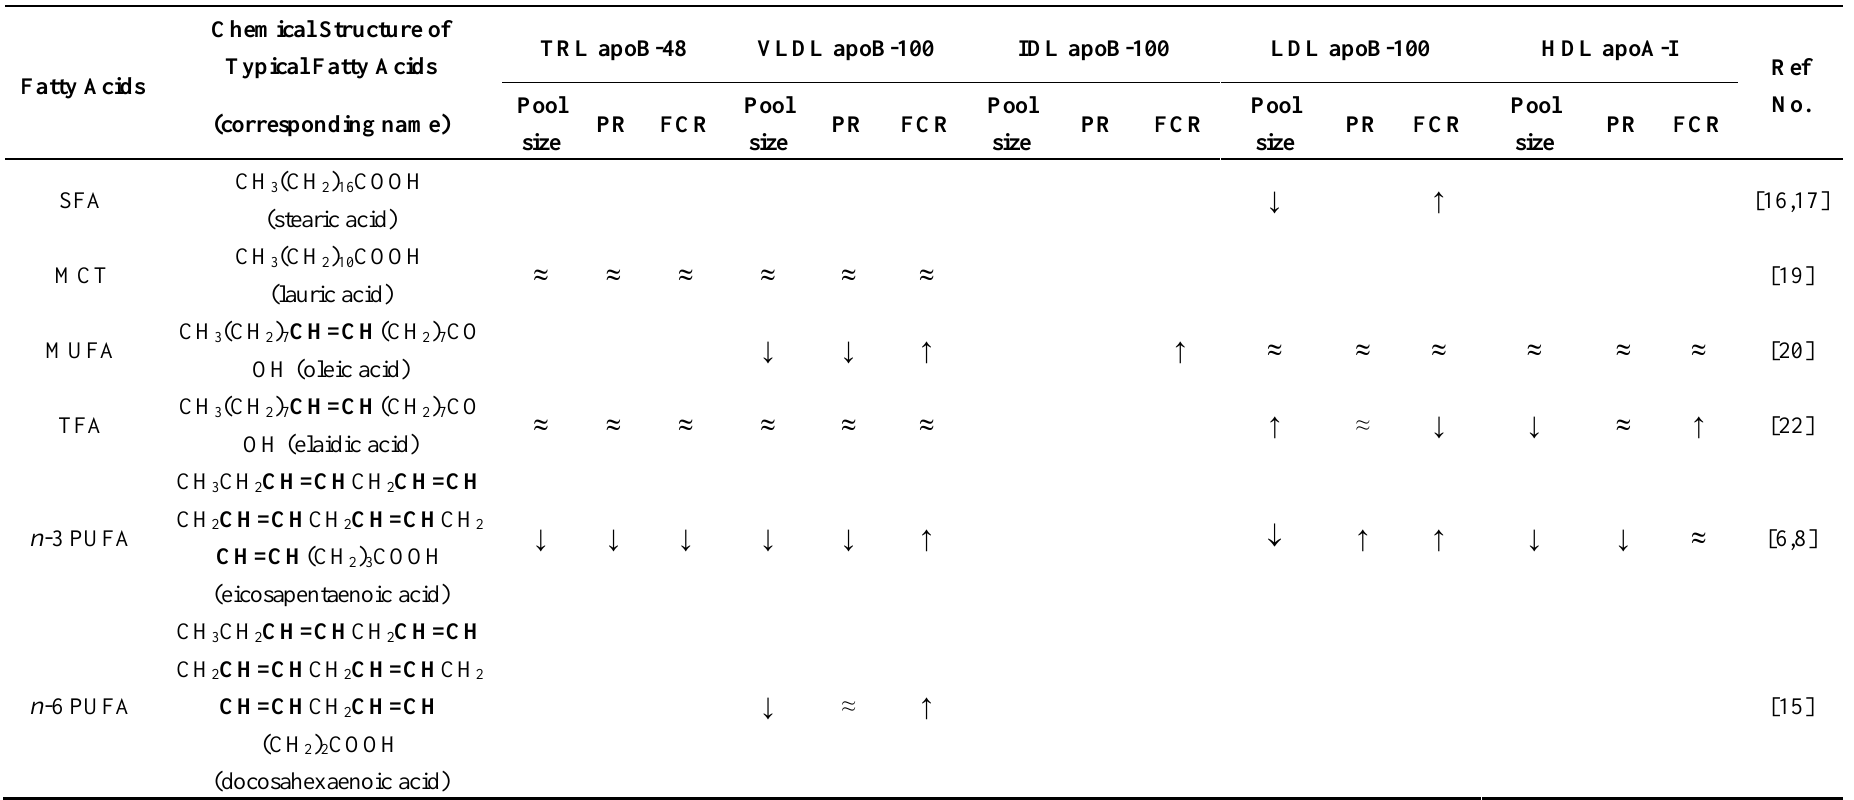
Table 1. Summary of the current findings on the effect of dietary fatty acids on indices of lipoprotein metabolism in human.